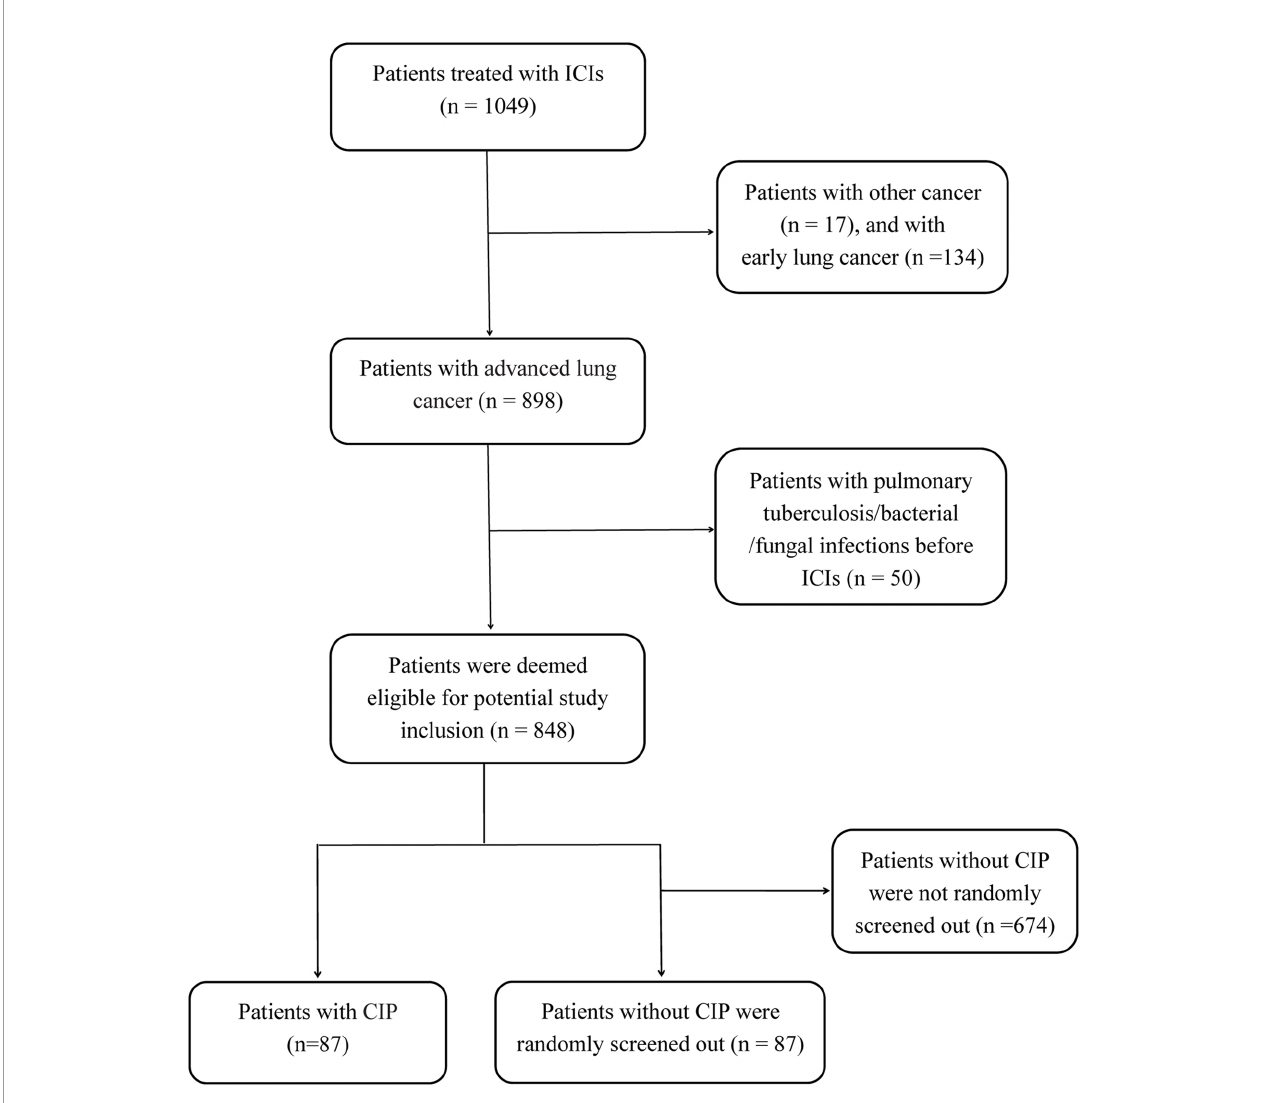
FIGURE 1 | The fl ow chart of study design and patients inclusion. ICIs, immune checkpoint inhibitors; CIP, checkpoint